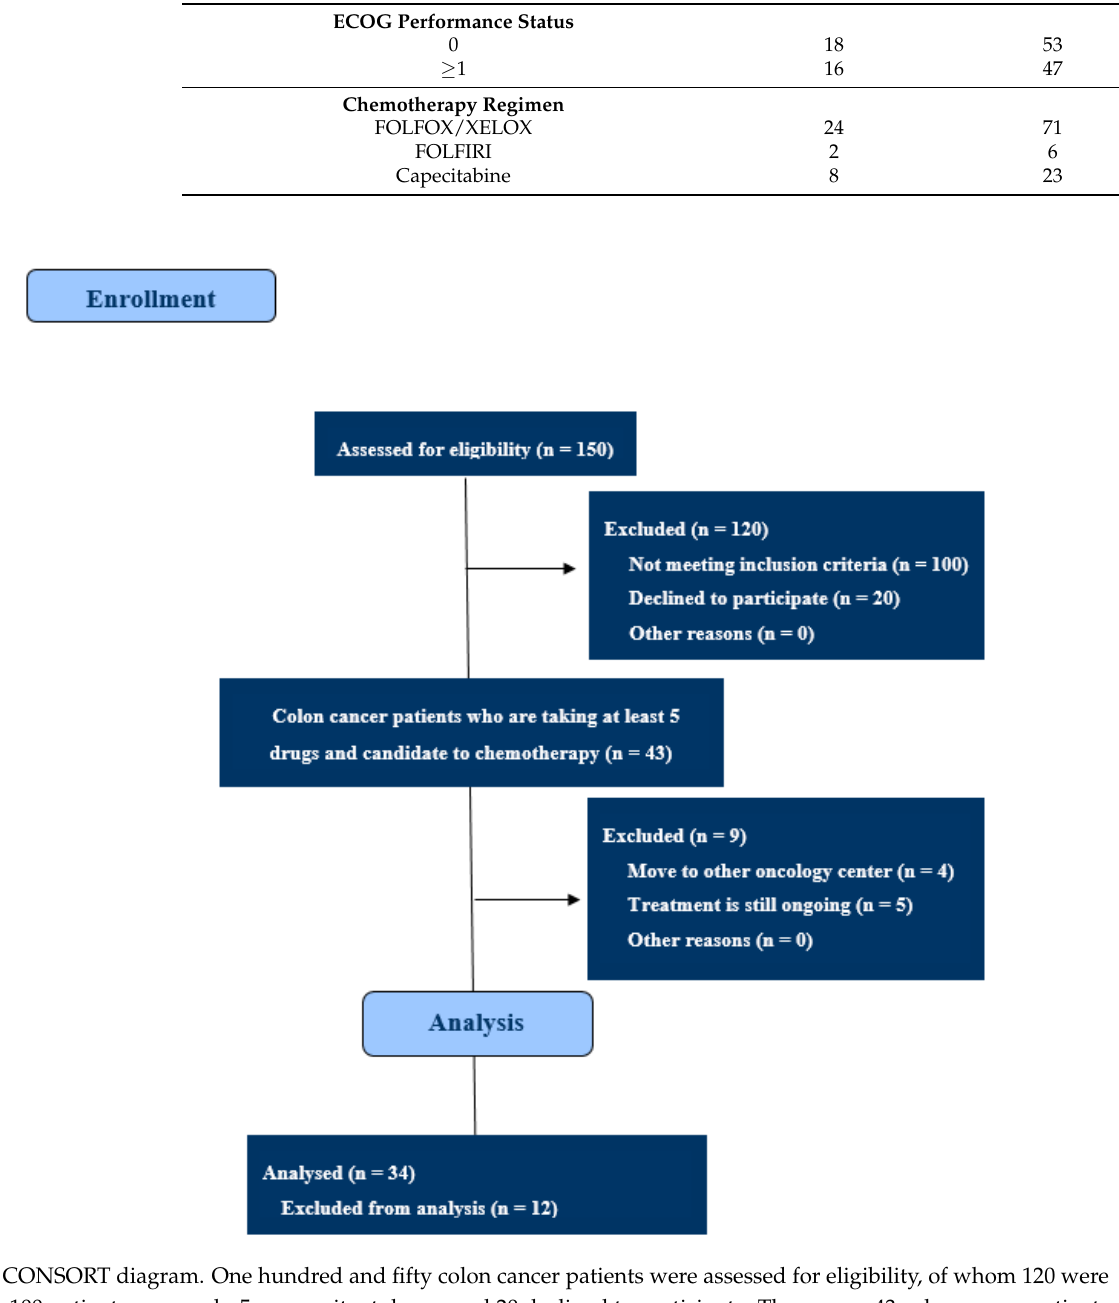
Figure 2. CONSORT diagram. One hundred and fifty colon cancer patients were assessed for eligibility, of whom 120 were excluded: 100 patients assumed <5 concomitant drugs, and 20 declined to participate. There were 43 colon cancer patients who were taking at least 5 drugs and were candidates for chemotherapy, of whom 12 were excluded from analysis.